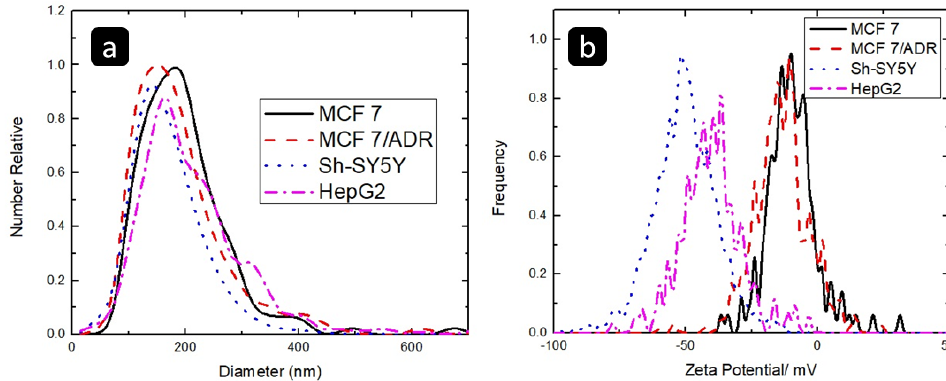
Figure 2. ( a ) The Zeta-sizer measurements and ( b ) The Zeta potential for the MCF7, MCF7/ADR, Sh-SY5Y, and HEPG2 isolated exosomes. The Zeta potential peaks for the MCF7, MCF7/ADR, SH -SY5Y, and HEPG2 isolated exosomes were at − 11.3 mV, − 11.6 mV, − 51 mV, and − 3 7.8 m V, respectively as shown in Figure 2b. The Zeta potential values of the exosomes isolated from SH-SY5Y and HEPG2